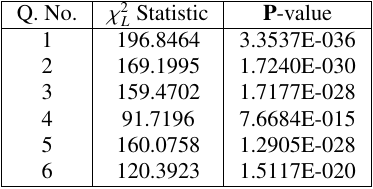
Table 6: χ 2 -statistic and P -value for all the questions L The Friedman test was performed again on the ranking’s ob- tained from the earlier post-hoc analysis (see Table [7]). The Q -statistic is found out to be 116.3224 and the corresponding p- value is found out to be 9.9362E-020. Thus at a significance level of α = 0 . 05, the hypothesis that all the visualization schemes are equally e ff ective cannot be accepted. A post-hoc analysis is